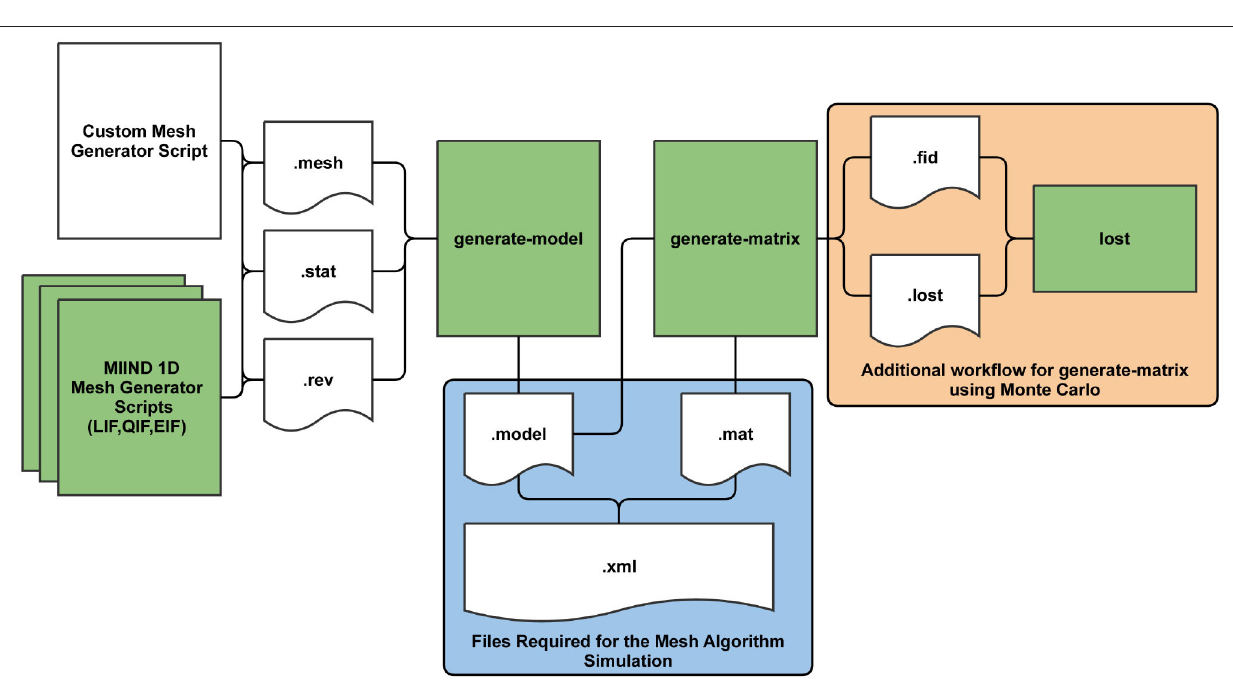
of the mesh). However, better efficiency is achieved by using the appropriate